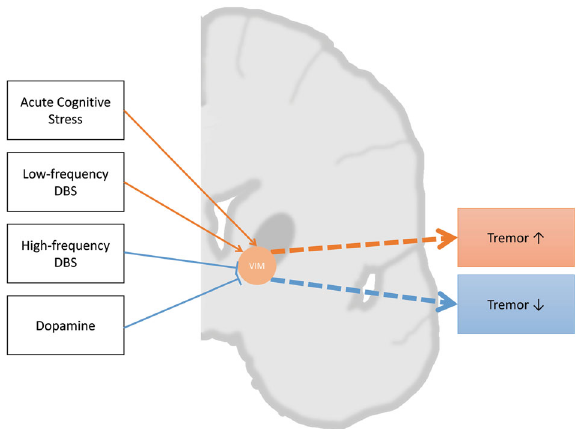
Fig. 3 Ventral intermediate nucleus of the thalamus (VIM) plays a central role in tremor activity and may be a target of tremor interference. Acute cognitive stress, deep brain stimulation (DBS), and dopamine could in fl uence VIM and thus regulate tremor. DBS with different frequency present a different effect on tremor activity. Orange arrows indicate excitatory effect, blue arrows indicate inhibitory